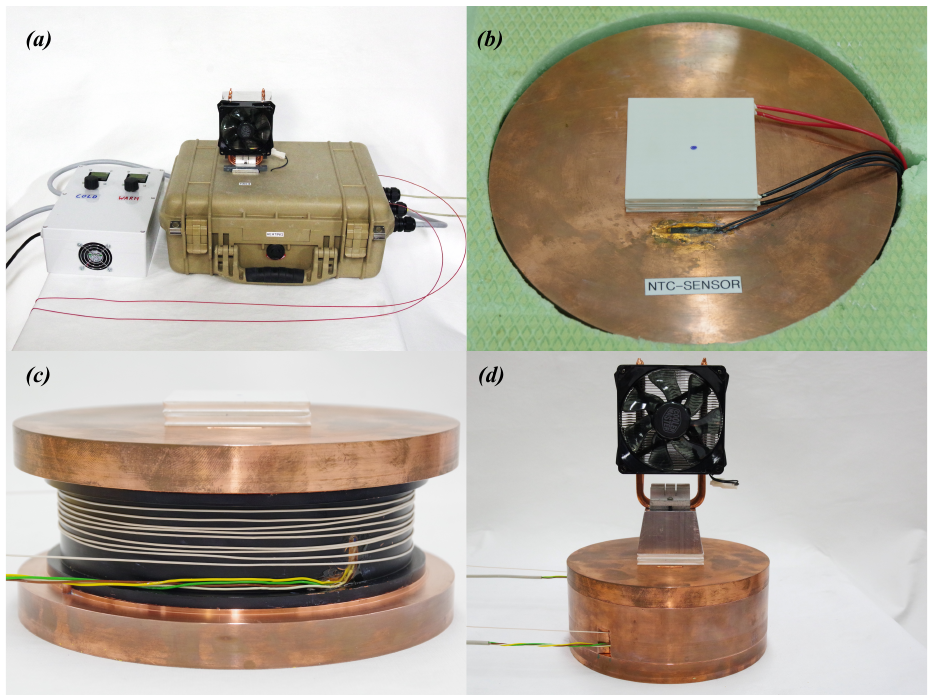
Figure 2. Overview and details of the copper Solid-Phase Bath (SoPhaB) used for referencing fiber- optic distributed mesurements: ( a ) One SoPhaB mounted in carrying case and control electronics as used in the field deployments with a 1.12 mm outer diameter stainless steel, red polyethylen coated single-core multimode fiber-optic cable used in data set “Windtunnel”, see Table 1; ( b ) Detailed view of the top slab with a stack of two Peltier elements of 62 mm × 62 mm dimensions, the NTC thermometer senses the copper body temperature and is connected to the control electronics; ( c ) Detailed view of the inner core painted with high-emissivity paint containing 8 coils of the tightly buffered, aramid reinforced 0.9 mm outer diameter PVC encased single-core multimode fiber-optic cable used in the field experiments (Table 1), also shown is the reference platinum wire (Pt100) thermometer embedded in the outer wall of the inner core connected to the DTS instrument to sense the reference temperature; ( d ) View of the SoPhaB’s assembled copper elements outside of the carrying case with aluminum block and CPU cooler. All parts and supply materials to construct one pair are listed in Tables A1 and